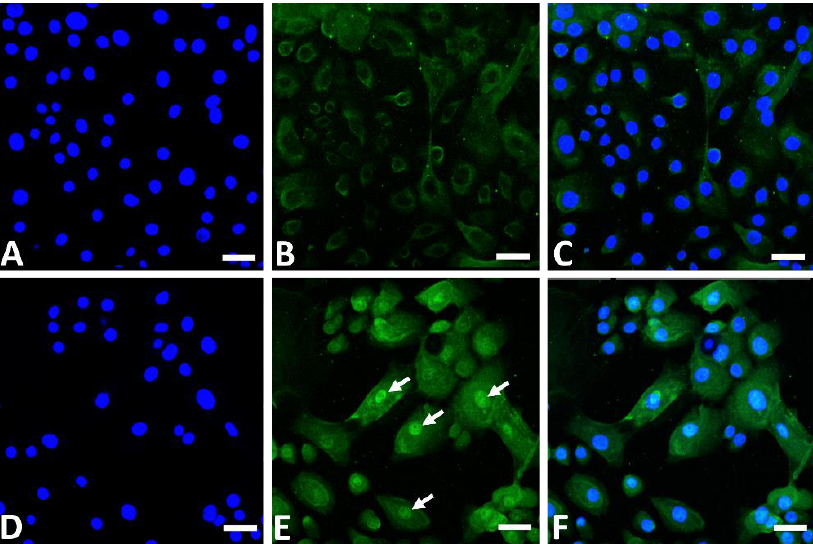
Figure 3. Immunofluorescence staining of NRF2 (green fluorescence) in human keratinocytes. Nonstimulated control keratinocytes (( A ); DAPI staining, ( B ); NRF2 staining, ( C ); merged). GFF-treated keratinocytes (( D ); DAPI staining, ( E ); NRF2 staining, ( F ); merged). NRF2 mainly resides in the cytoplasm in nonstimulated keratinocytes ( B ). GFF induces nuclear translocation of NRF2 (( E ), arrows). DAPI: 4′,6 -diamidino-2-phenylindole. NRF2: nuclear factor erythroid-2-related factor 2. GFF: Galactomyces ferment filtrate. Bar; 25 μm.